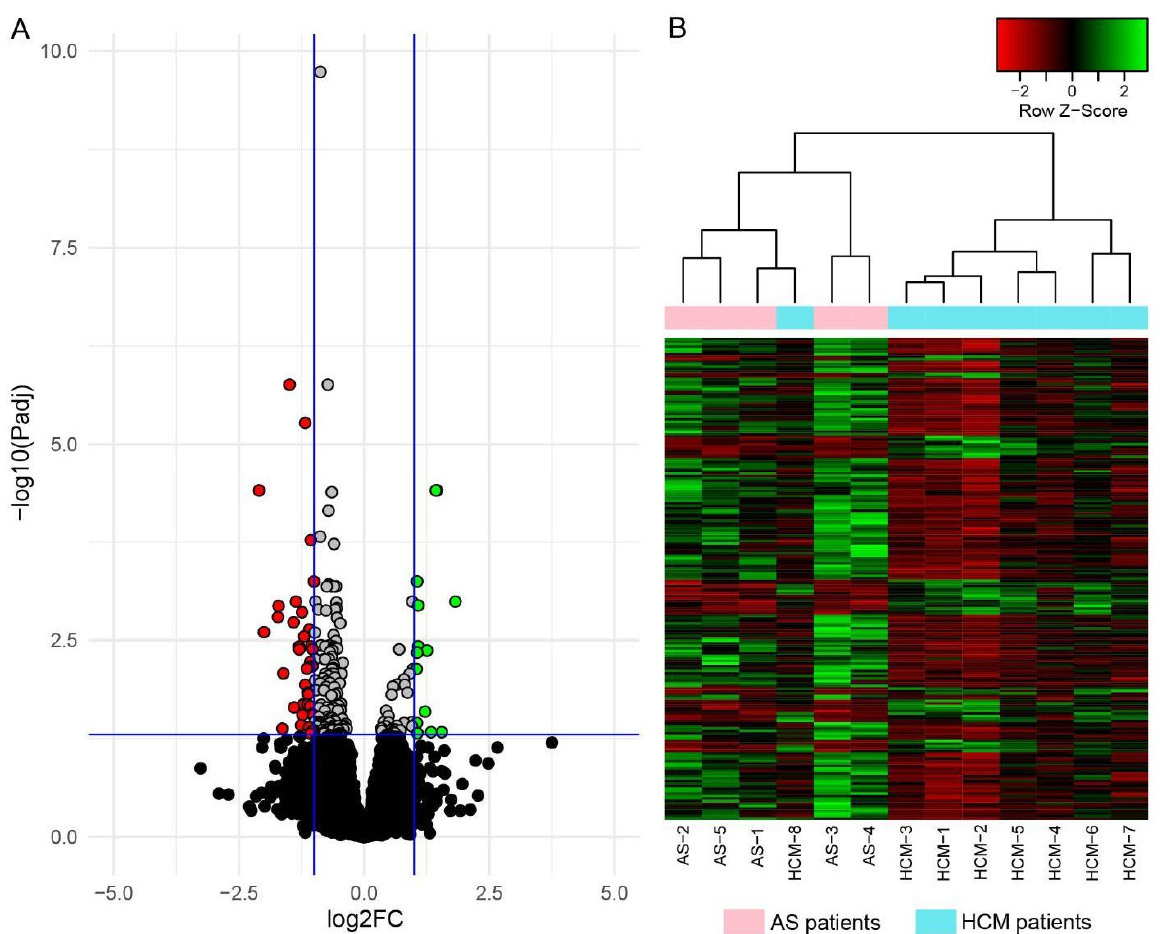
Figure 1. Visualization of the DEGs identified in the LV myocardial tissue of HCM patients when compared to AS patients. ( A ): Volcano plot of gene expression levels. Blue vertical lines indicate threshold for expression differences |log2FC| = 1; blue horizontal line—threshold for statistical significance (padj = 0.05). Significantly downregulated genes (padj < 0.05, log2FC < − 1) are marked in red; significantly upregulated genes (padj < 0.05, log2FC > 1)—in green; genes with padj < 0.05 that do not exceed the threshold |log2FC| = 1—in gray. ( B ): Heatmap of z-scored expression levels of 193 identified DEGs in all studied patients. Decreased expression levels of DEGs are marked in red, and increased levels—in green. Top dendrogram shows hierarchical clustering of RNA samples. Cyan indicates RNA samples from HCM patients; pink—from AS patients.